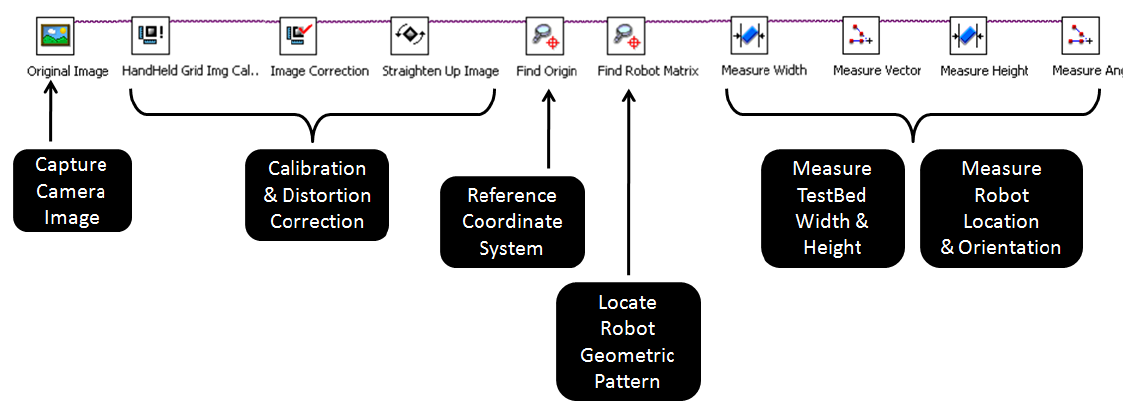
Figure 11. Tracking Algorithm